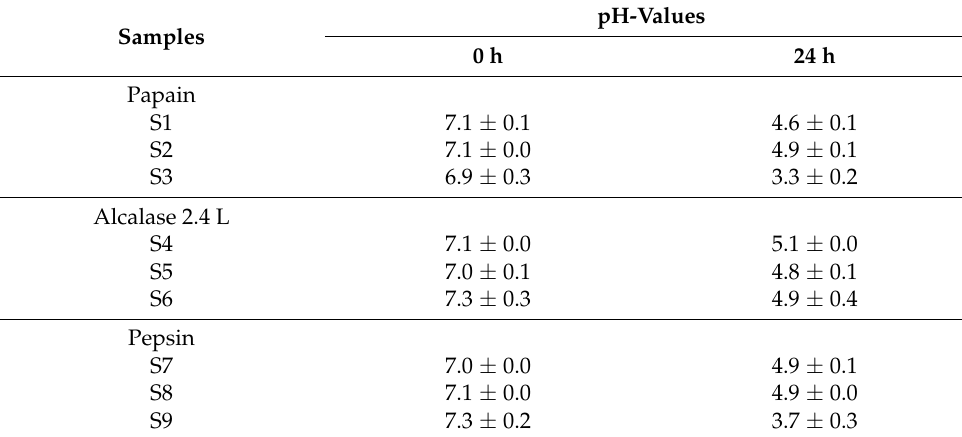
Table 5. pH values after 0 h and 24 h of fermentation.